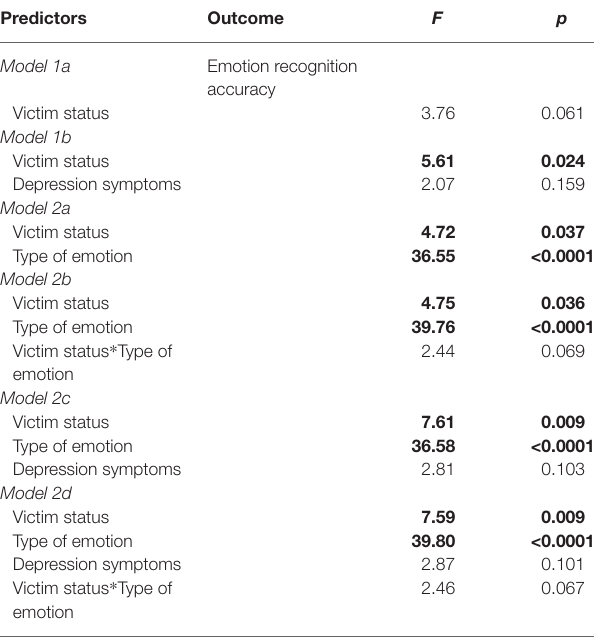
TABLE 3 | Associations between victimization status and emotion recognition accuracy and moderation effects of type of